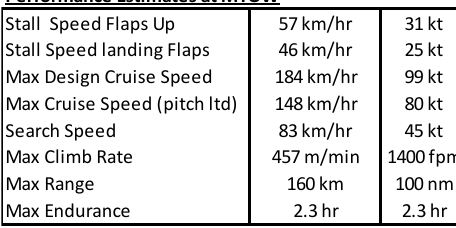
Tables 8: Performance estimates for TD100E